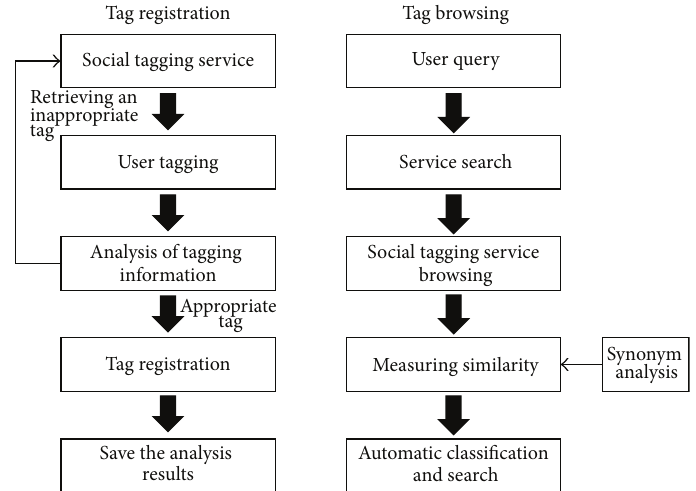
Figure 1: Overall proposed method.